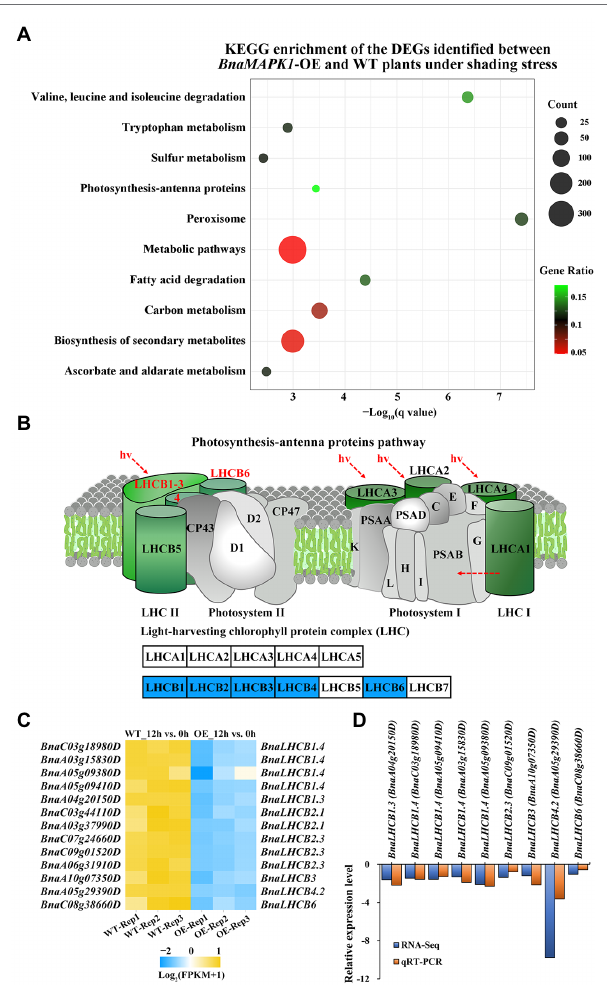
FIGURE 5 | Photosynthesis-antenna proteins downregulated in BnaMAPK1 - OE rapeseed relative to WT plants under shading stress in RNA-Seq. (A) Top 10 significantly enriched KEGG pathways in the 3,000 DEGs in 12h_ OE vs. WT pairwise comparisons. The advanced bubble chart shows the enrichment of the DEGs in the signaling pathways. The x -axis label represents the enrichment significance ( q-value < 0.05), and the y -axis label indicates the pathway names. The size of the circle represents the number of genes enriched in a particular pathway, and the color of bubble presents the enrichment factor (gene ratio = amount of DEGs enriched in the pathway/total number of genes in background gene set). (B) Downregulated BnaLHCBs encoding LHCB subunits in KEGG map of PS II-LHC II supercomplex in 12h_ OE vs. WT pairwise comparisons. (C) Heatmap clustering of 13 BnaLHCBs transcript abundances associated with photosynthesis-antenna proteins pathway. Each DEG was screened with FPKM value of three replicates > 1, |Log 2 FC| > 1, and FDR < 0.05. (D) The relationship comparison between qRT-PCR and RNA-Seq fold change results.